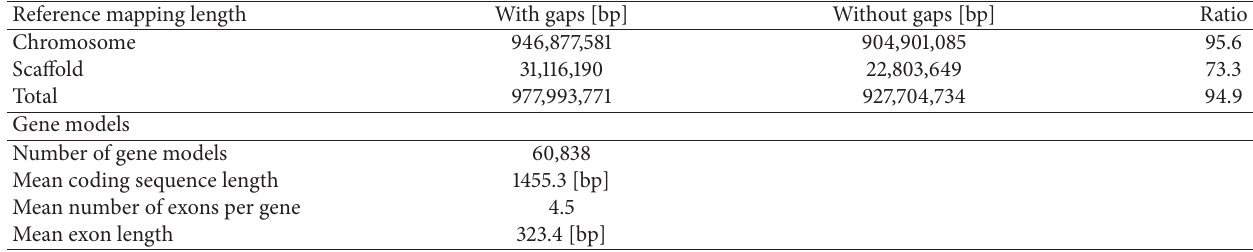
Table 1: Genome assembly and annotation of G. max cv.